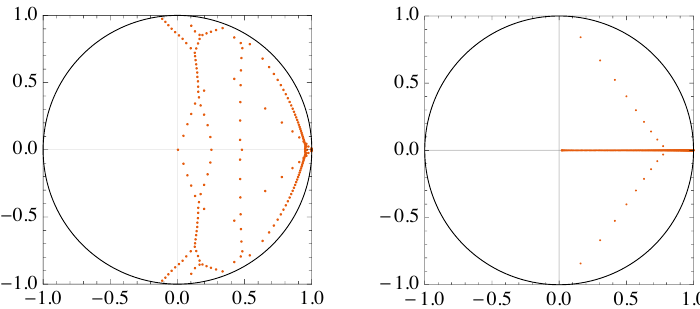
Figure 9 . Distribution of eigenvalues of J Ψ for a pure elastic scattering amplitude consisting of a singe CDD-pole and a CDD-zero. We plot it close to the boundary of convergence, here = 2 . 4 and m 2 = 3 . 98 with linear interpolation (left), while m 2 m 2 p z interpolation (right). As we move the location of zero closer to 4 , the support of distribution of zeros on the right panel moves to negative values for interpolation with Bernstein